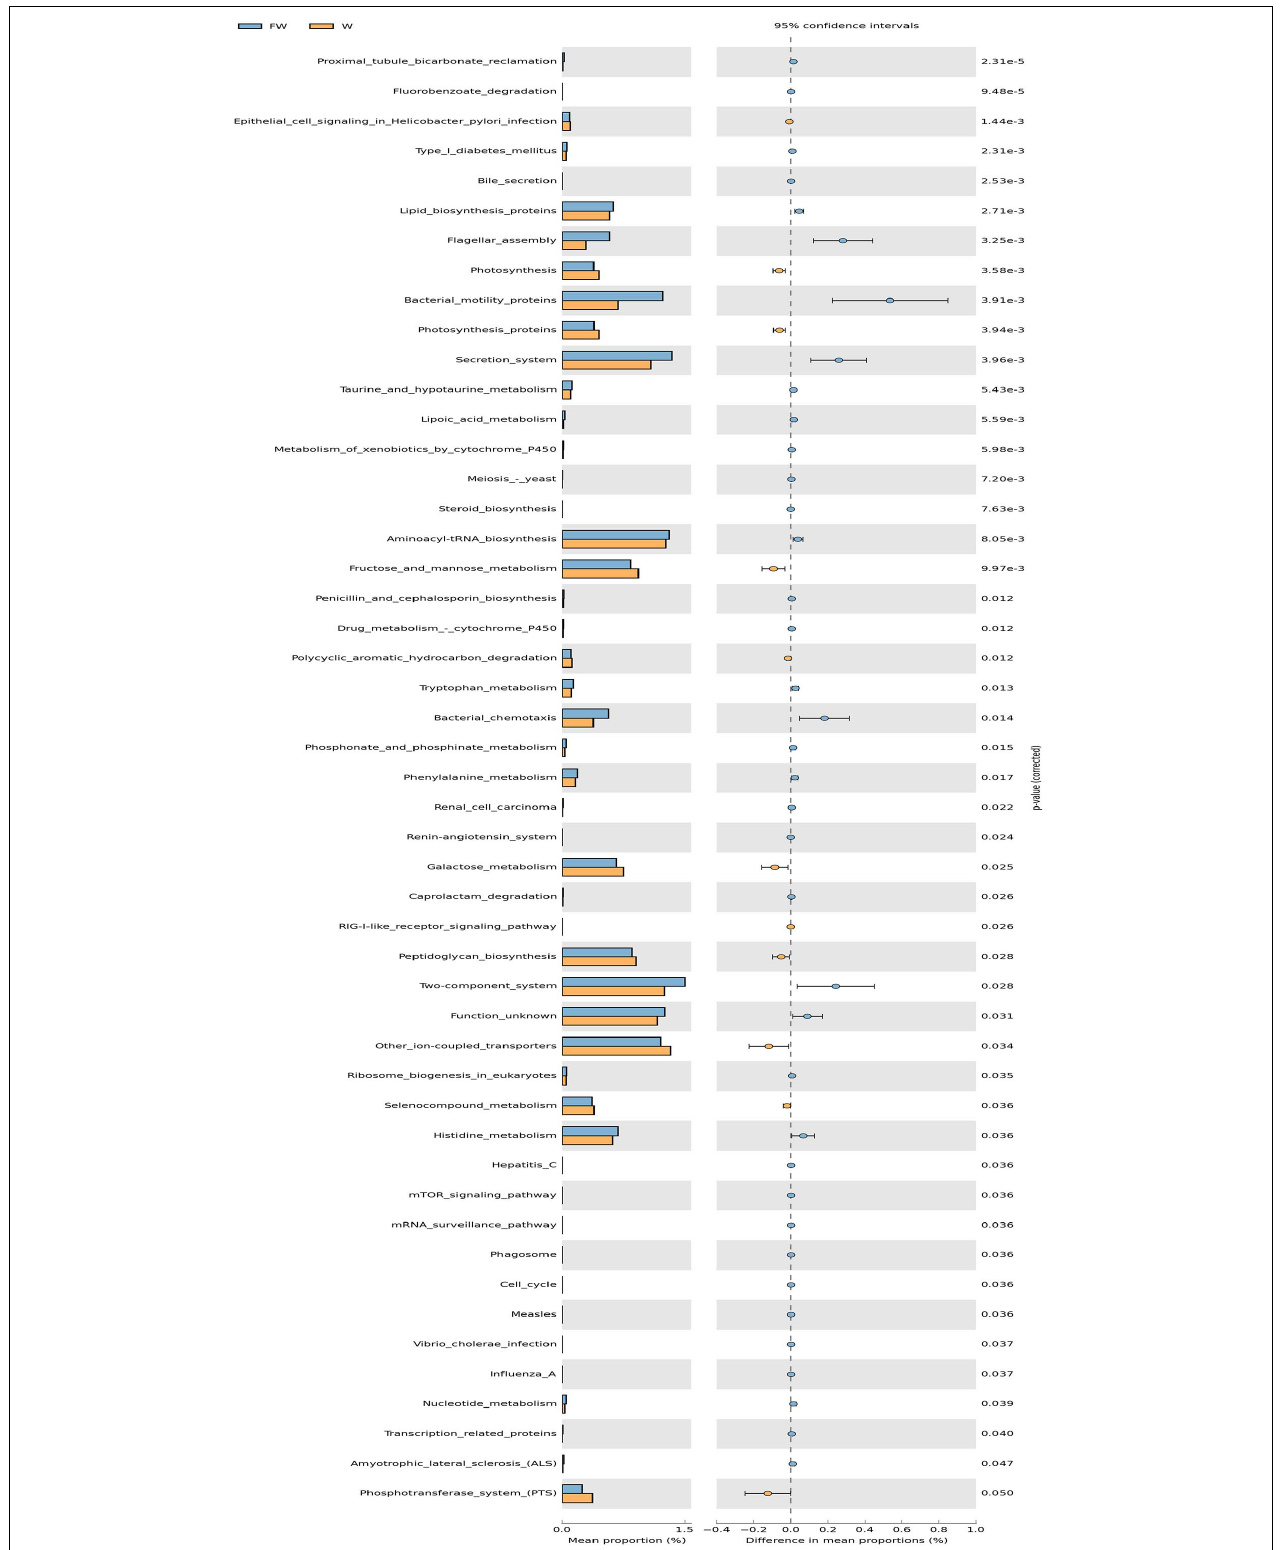
FIGURE 12 | The comparison of predicted microbial function between the W and FW groups. STAMP analysis was applied to identify the significant differences in the predictive functions at the third level of KEGG pathways between two groups. The P -values were shown at right (W, Weaned; FW, FMT+Weaned).